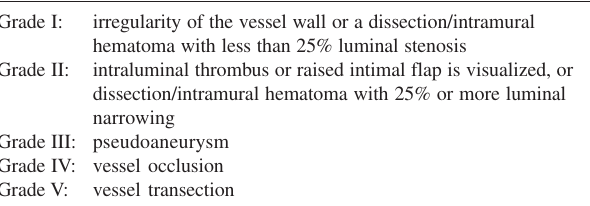
Table 2 - Denver grading scale for blunt cerebrovascular